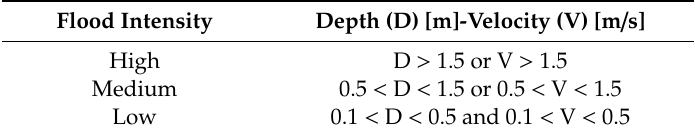
Table 3. Flood intensity as a function of flow velocities and water depth.